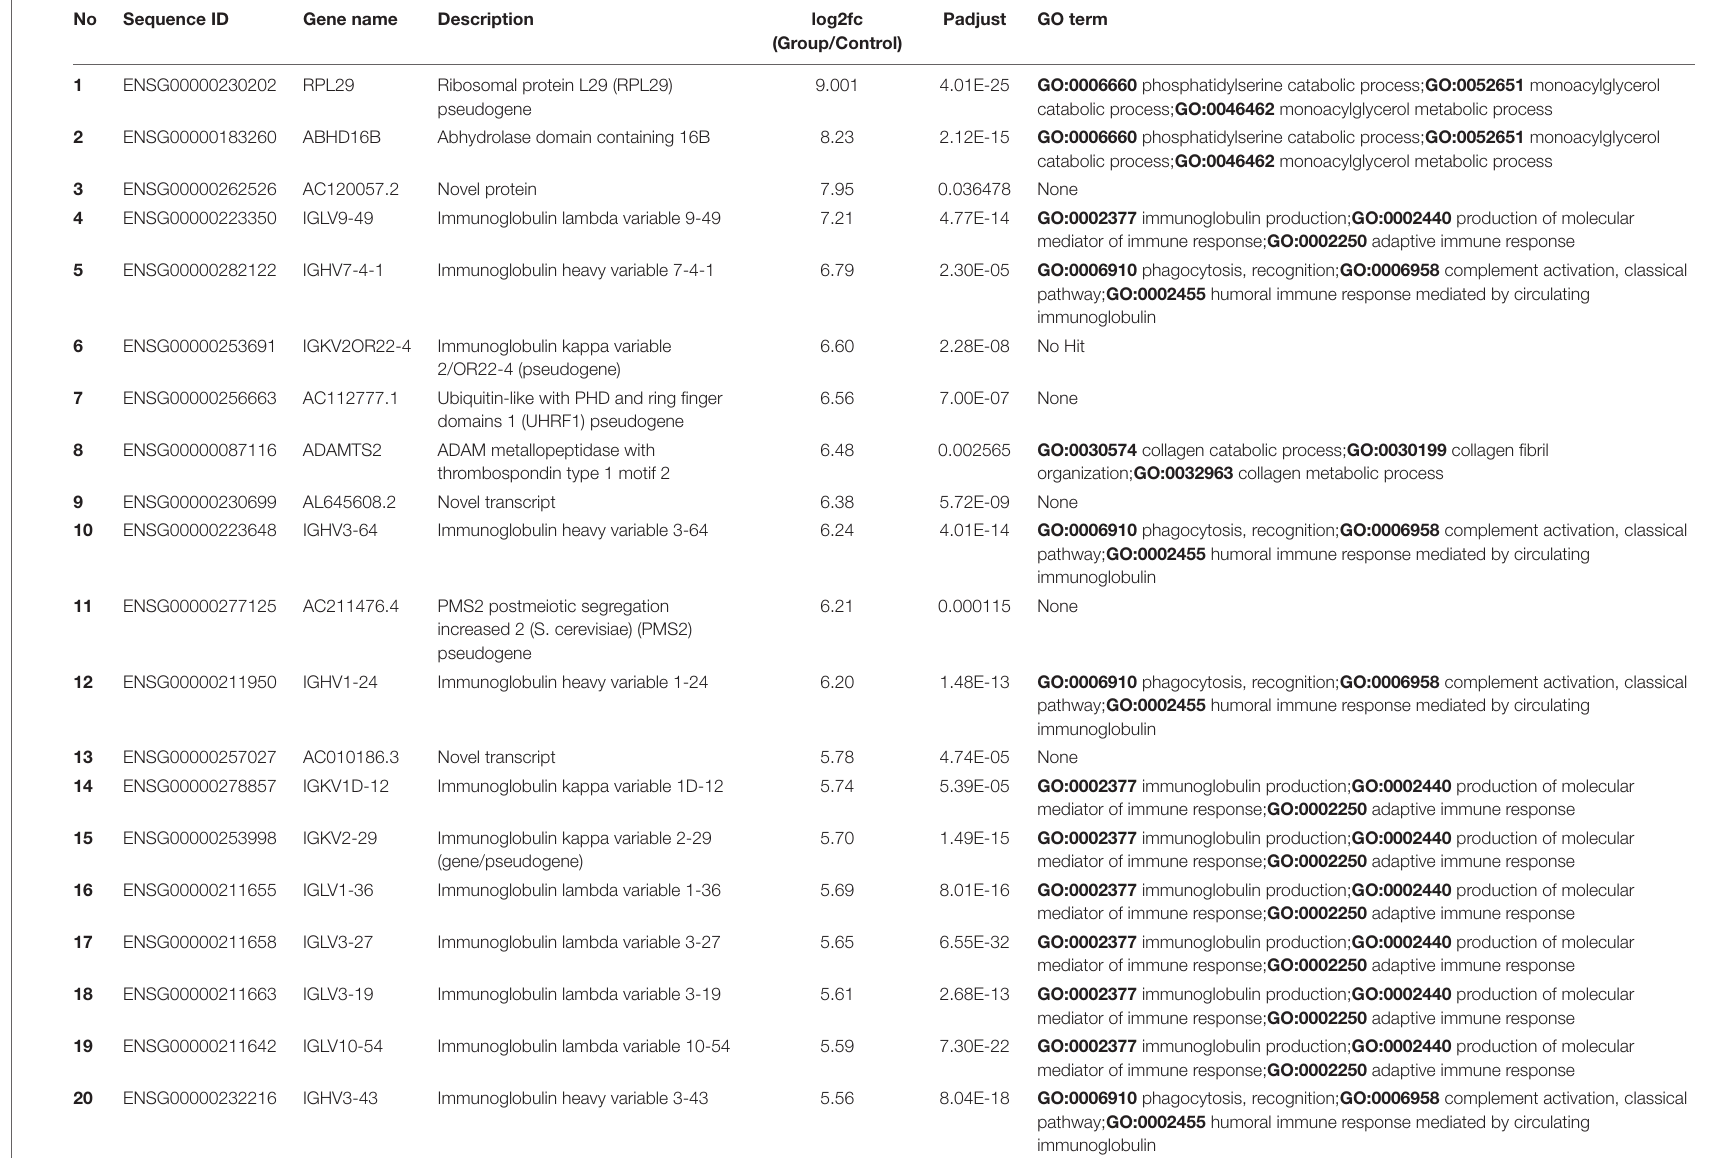
TABLE 1 | Top 20 upregulated differentially expressed genes and their GO terms and fold change (log2fc) values.